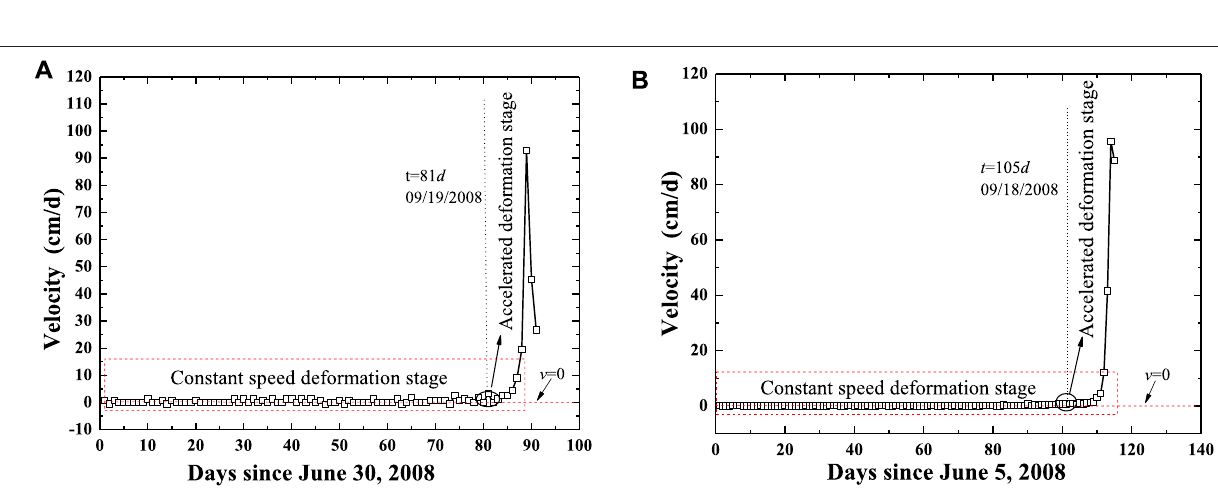
Frontiers in Earth Science |